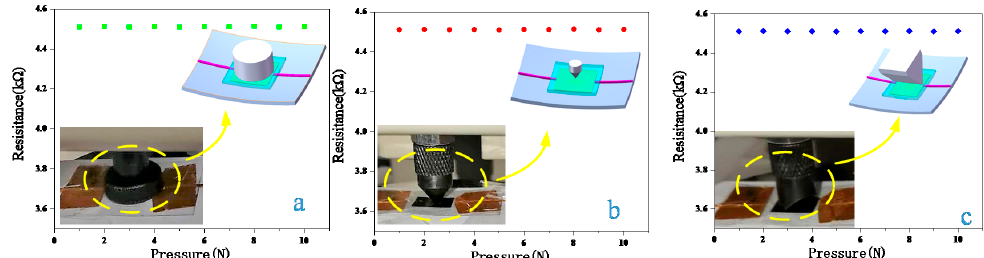
Figure 4. Layered structure model and SEM of r-GO: ( a ) schematic showing the layered structure model before pressure; ( b ) schematic illustrating the layered structure after pressure; ( c ) SEM image of the r-GO before pressure; ( d ) SEM image of the r-GO after pressure.